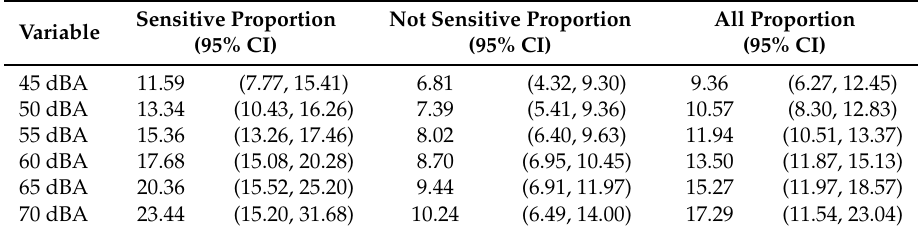
Table A11. L Night and marginal proportions of sleep disturbance by total environmental noise in the weighted study sample, adjusted for sensitivity to noise: marginal prediction by sensitivity.